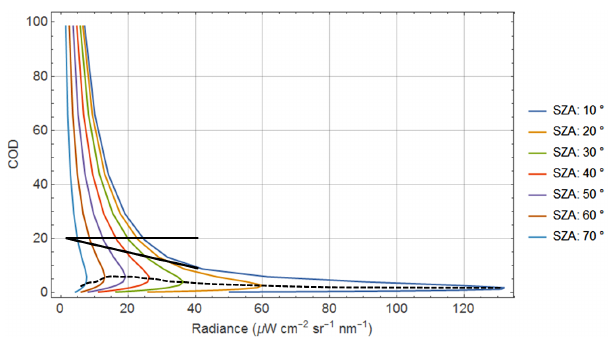
Figure 4. 440nm radiance to COD lookup tables for various SZAs. The radiance peak for each curve is its 1DRT “bright-point“ radi- ance. The black solid and dotted line markers are referred to in var- ious sections of the